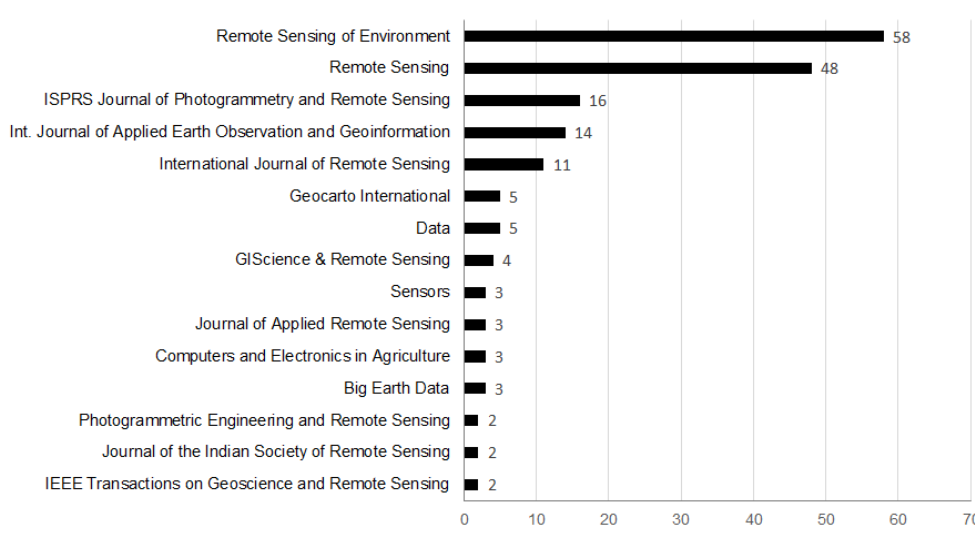
Figure 3. Top 15 journals where the selected papers were